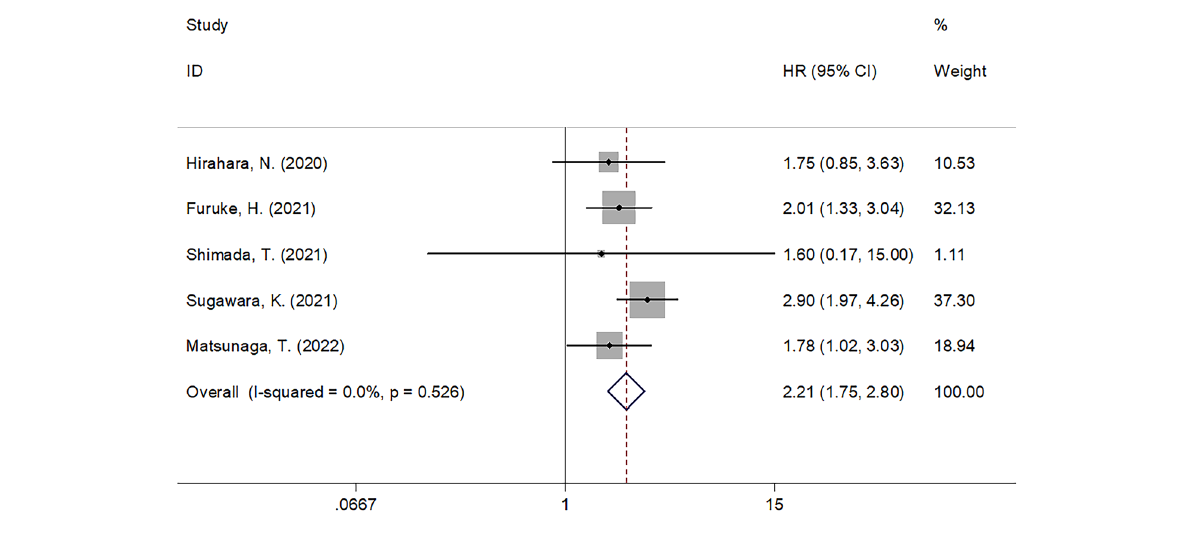
FIGURE 3 Forrest plots of the correlation between GNRI and CSS in GC